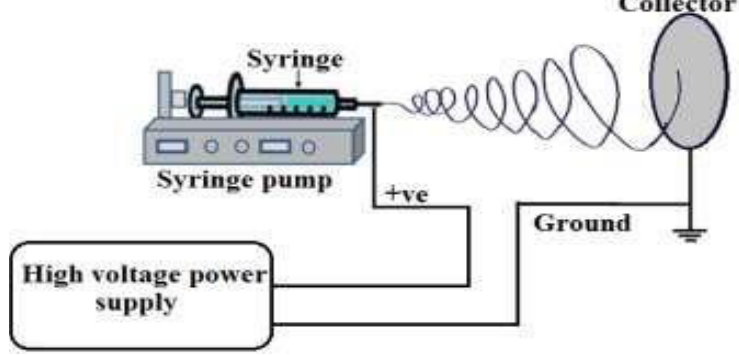
Figure 2. Used electrospinning setup schematic diagram.